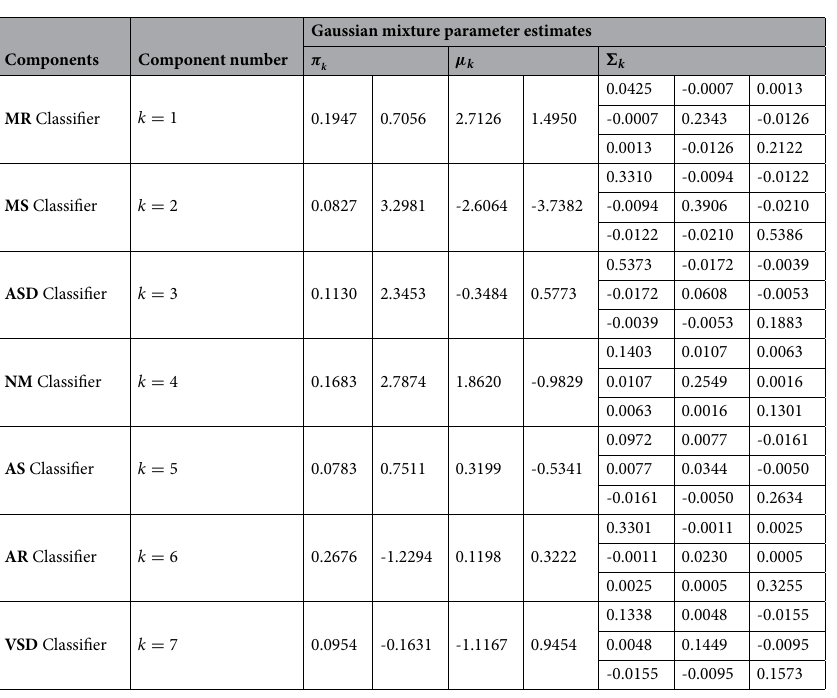
Table 4. The Gaussian mixture parameter estimates are achieved for the new features [ γ 1 , γ 2 , γ 3 ] by setting the number of Gaussian mixture components as